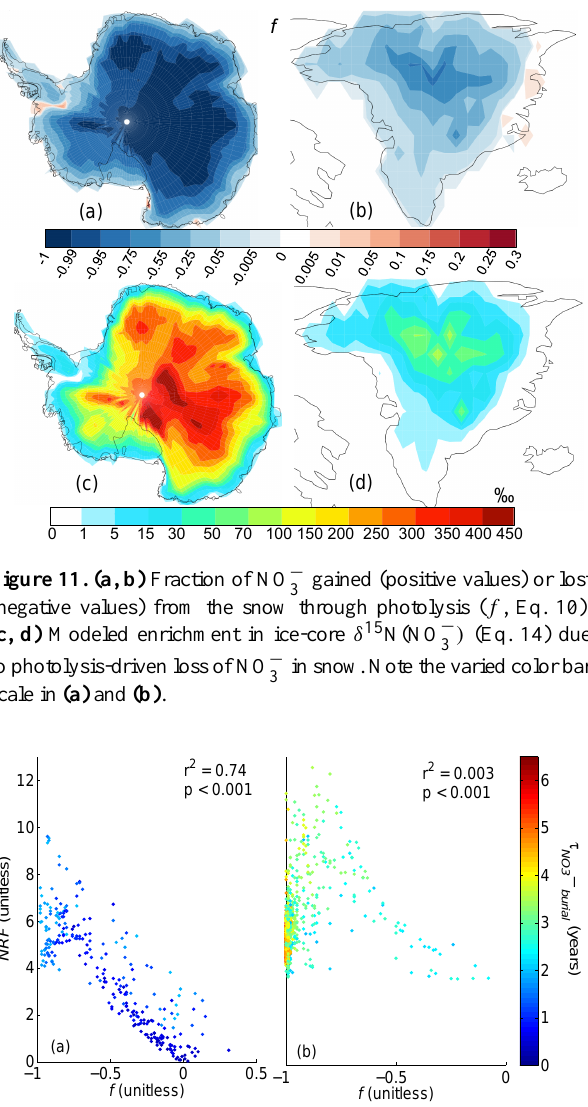
Figure 12. NRF versus f values across Antarctica. (a) Regions where NO − remains in the photic zone for 2 years or less. (b) Re- 3 gions where NO − remains in the photic zone for more than 2 years. 3 The color scale represents the number of years NO − ) . photic zone ( τ NO − 3 burial